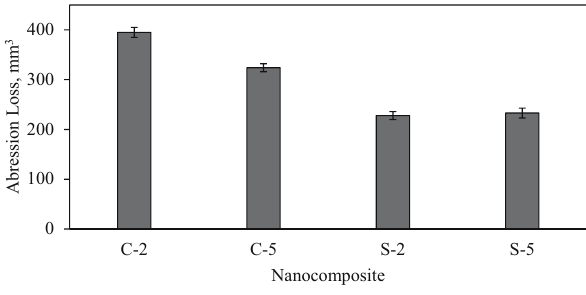
Figure 11: Abrasion loss of cured NR